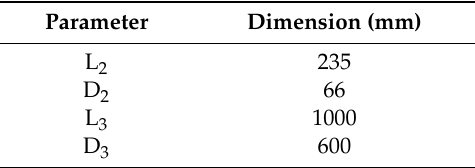
Table 1. Mesh test Table 1. Mesh test parameters.